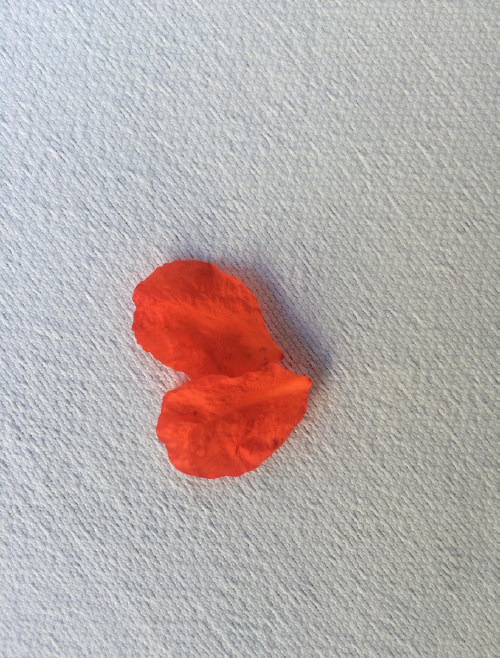
Figure 2 Figure 2. Petals of the Gul-i An¯ar (Pomegranate Flower). Photograph: Sylvia